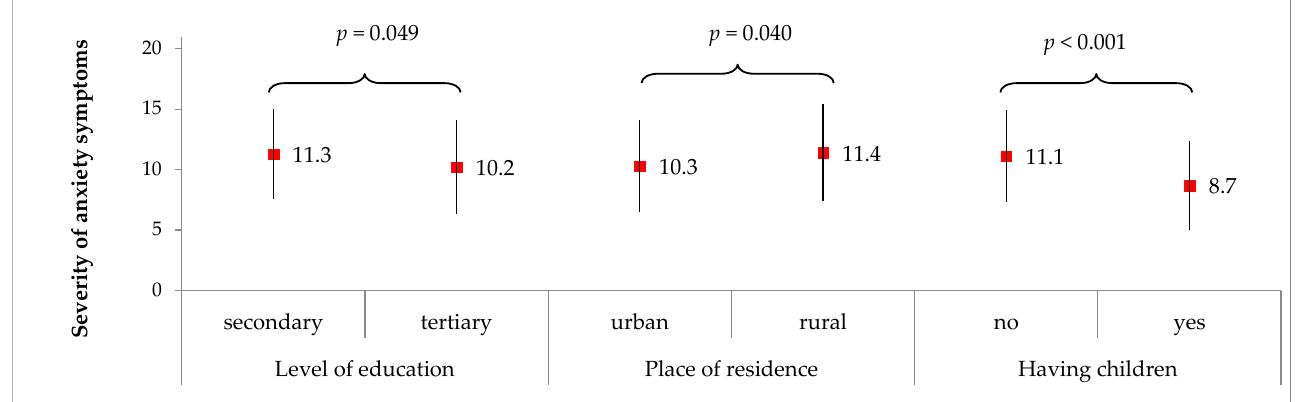
Figure 4. Significant correlations for the severity of anxiety symptoms acc. to HADS with socio- demographic characteristics in the PCOS group. Results are presented as mean ± standard deviation. p for Student’s t test.